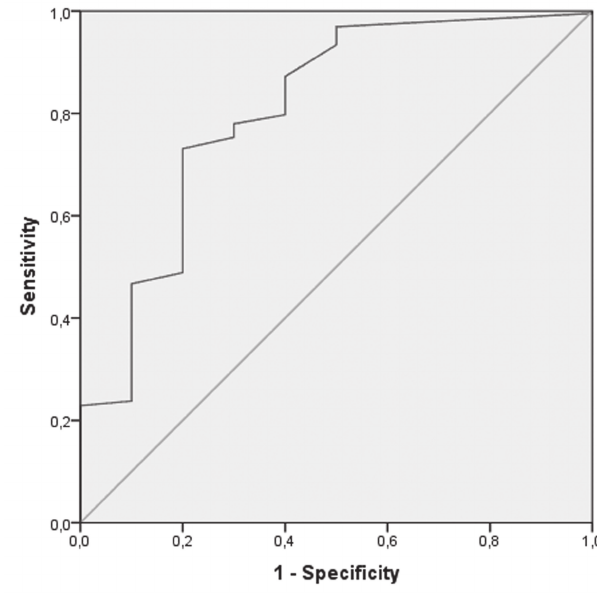
Figure 1 - ROC curve for predicting clinically significant cancer, based on TRUS guided biopsy